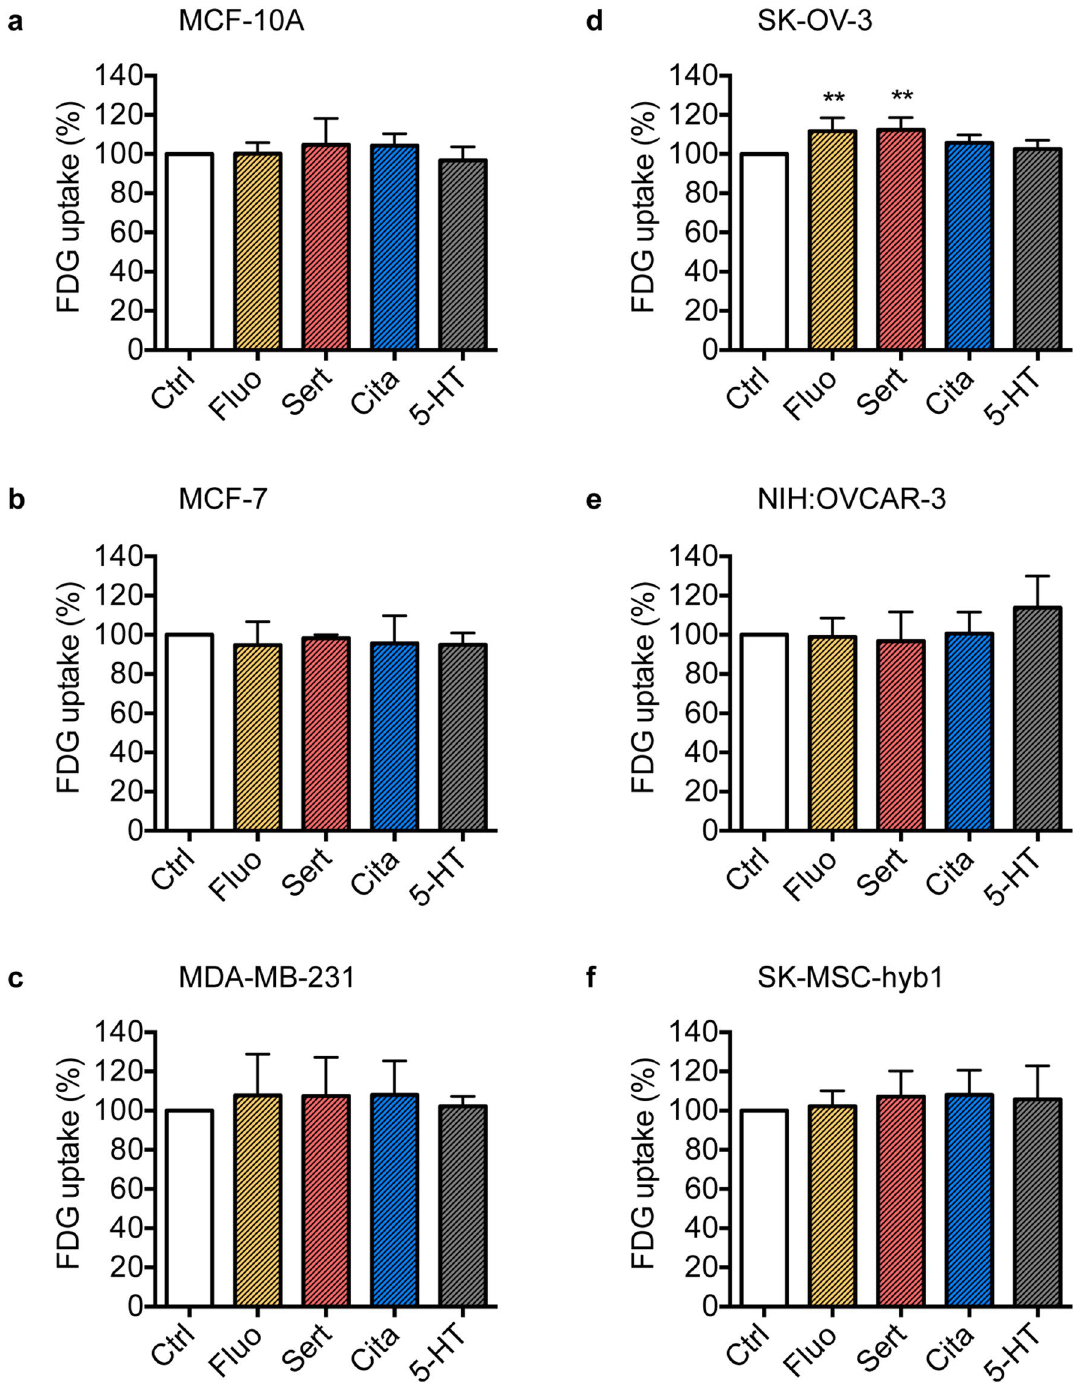
Figure 6. Fluoxetine and sertraline marginally increase glucose uptake in SK-OV-3 cells. Bar graphs depict relative cellular glucose uptake assessed by 18F-FDG incorporation of MCF-10A ( a ), MCF-7 ( b ) and MDA-MB-231 ( c ) breast cancer as well as SK-OV-3 ( d ) NIH:OVCAR-3 ( e ) and SK-MSC-hyb1 ( f ) ovarian cancer cells in response to stimulation with 1 µM fluoxetine (Fluo), sertraline (Sert), citalopram (Cita), or 5-HT relative to DMSO-treated control cells (Ctrl) for 72 h. Data, derived from n = 3 (b and e), n = 4 (a and c) or n = 5 (d and e) independent cell passages performed in duplicates, are depicted as means ± SEM. P -values were computed by one-way ANOVA followed by Dunnett’s multiple comparison test; ** P <